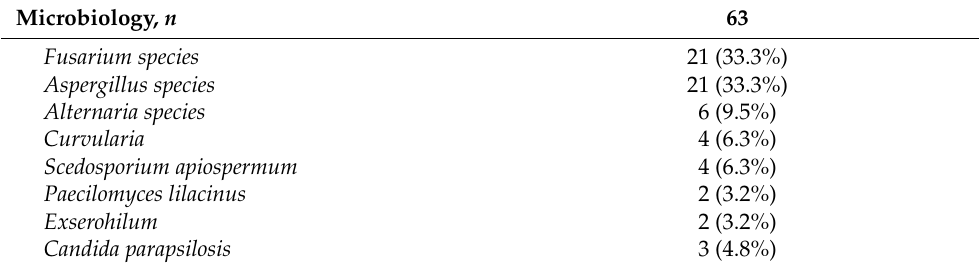
Table 2. Fungal species isolated from culture-positive patients with FK ( n =